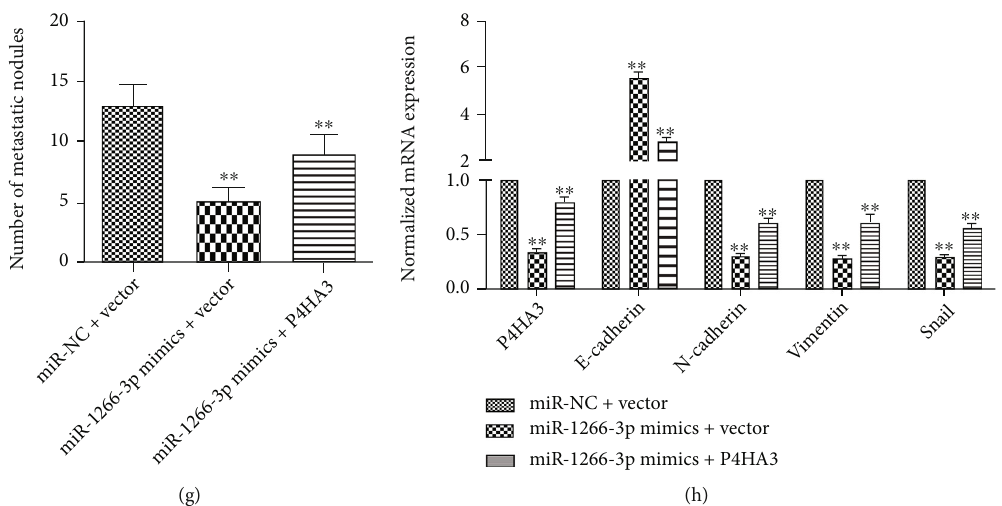
Figure 5: MiR-1266-3p inhibited EMT by targeting P4HA3 in colon cancer cells. (a) The reverse e ff ect of P4HA3 overexpression on miR- 1266-3p-mediated changes in EMT-associated proteins in SW480 cells by western blot. (b) The reverse e ff ect of P4HA3 overexpression on miR-1266-3p-mediated changes in EMT-associated proteins by western blot in HT29 cells. (c – e) Tumor size was calculated every three days after tumor formation. The tumors were stripped and weighed after 25 days of injection ( ∗∗ P < 0 : 01 ). (f – g) In vivo metastatic assay by spleen injection revealed miR-1266-3p suppressed colon cancer hepatic metastasis by targeting P4HA3 ð ∗∗ P < 0 : 01 Þ . (h) Detection of P4HA3 and EMT-related markers expression in liver metastatic nodules by qRT-PCR ( ∗∗ P < 0 : 01